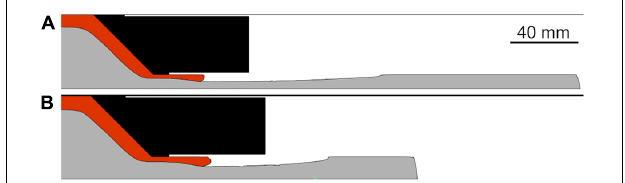
FIGURE 3 | Runs No. 12 (A) and 15 (B) with different lengths of the nose